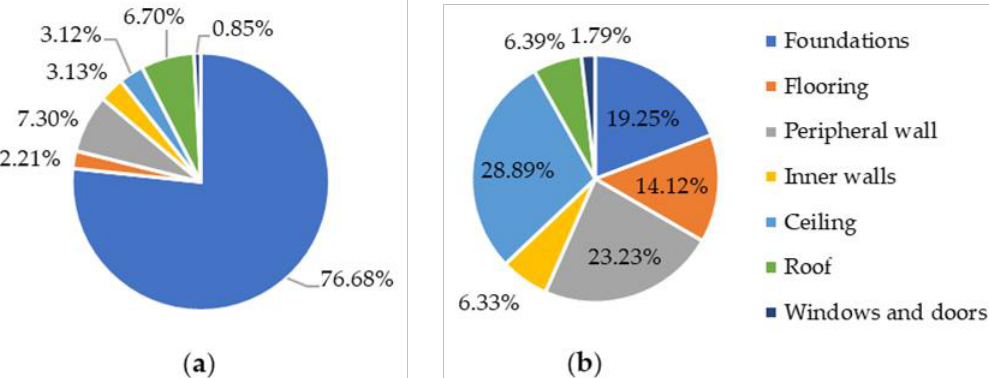
Figure 6. Distribution of construction components within the whole construction: ( a ) weight distribution; ( b ) volume distribution. Table 2. Total life cycle impact assessment